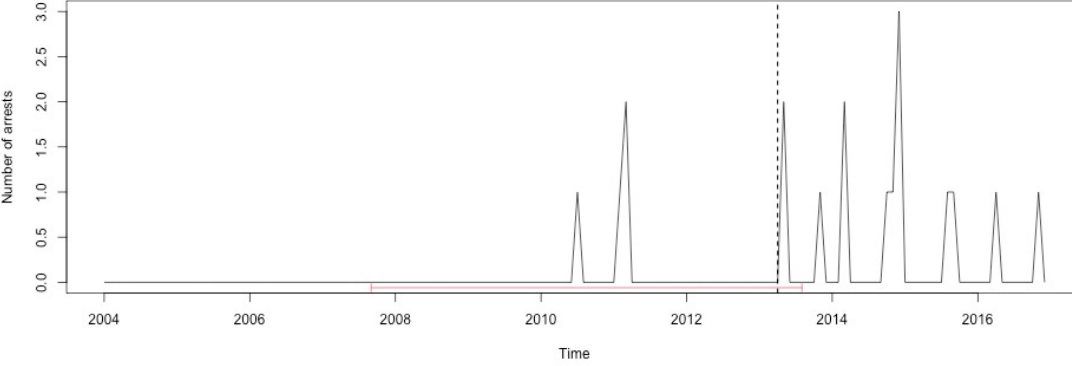
Figure A33. Precursor foreign nationals arrests 2004–2016 in the Czech Republic and structural breaks.